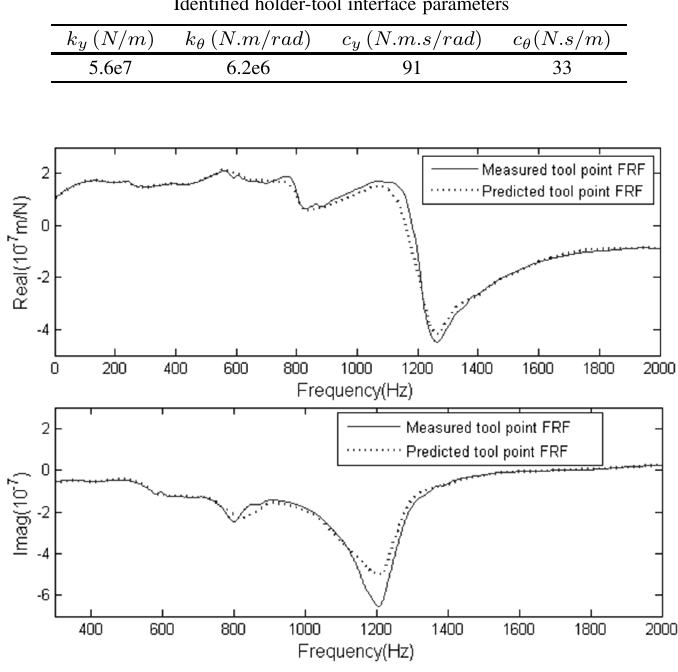
Fig. 8. Predicted and measured tool point FRF of the XHK machining